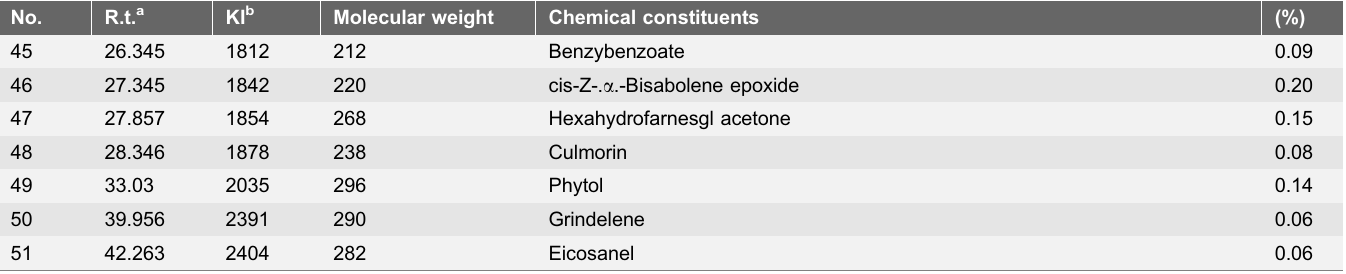
a moderate inhibitory effect on PGE2 production. At the concentration of 100 m g/ ml, PEG2 production decreased by 40%. Meanwhile, Fig. 3C showed that the number of viable activated cells remained unchanged significantly, indicating that the inhibitory effect of MEO on NO and PGE2 was not simply due to the cytotoxic effect, and MEO had no adverse effect on RAW 264.7 cells. NO is an endogenous free radical species synthesized from L-arginine by nitric oxide synthase in various animal cells, and is recognized as a mediator in pathological reactions, especially in acute inflammatory responses [18]. PGE2 is also an important inflammatory mediator involved in the pathogenisis. Thus NO and PGE2 production is usually measured for assessing the anti-inflammatory effect. Pharmacological studies have shown that essential oil derived from various plant materials possesses anti-inflammatory activities [19, 20]. In the present study, MEO showed a notable in vivo and in vitro anti-inflammatory effect. The